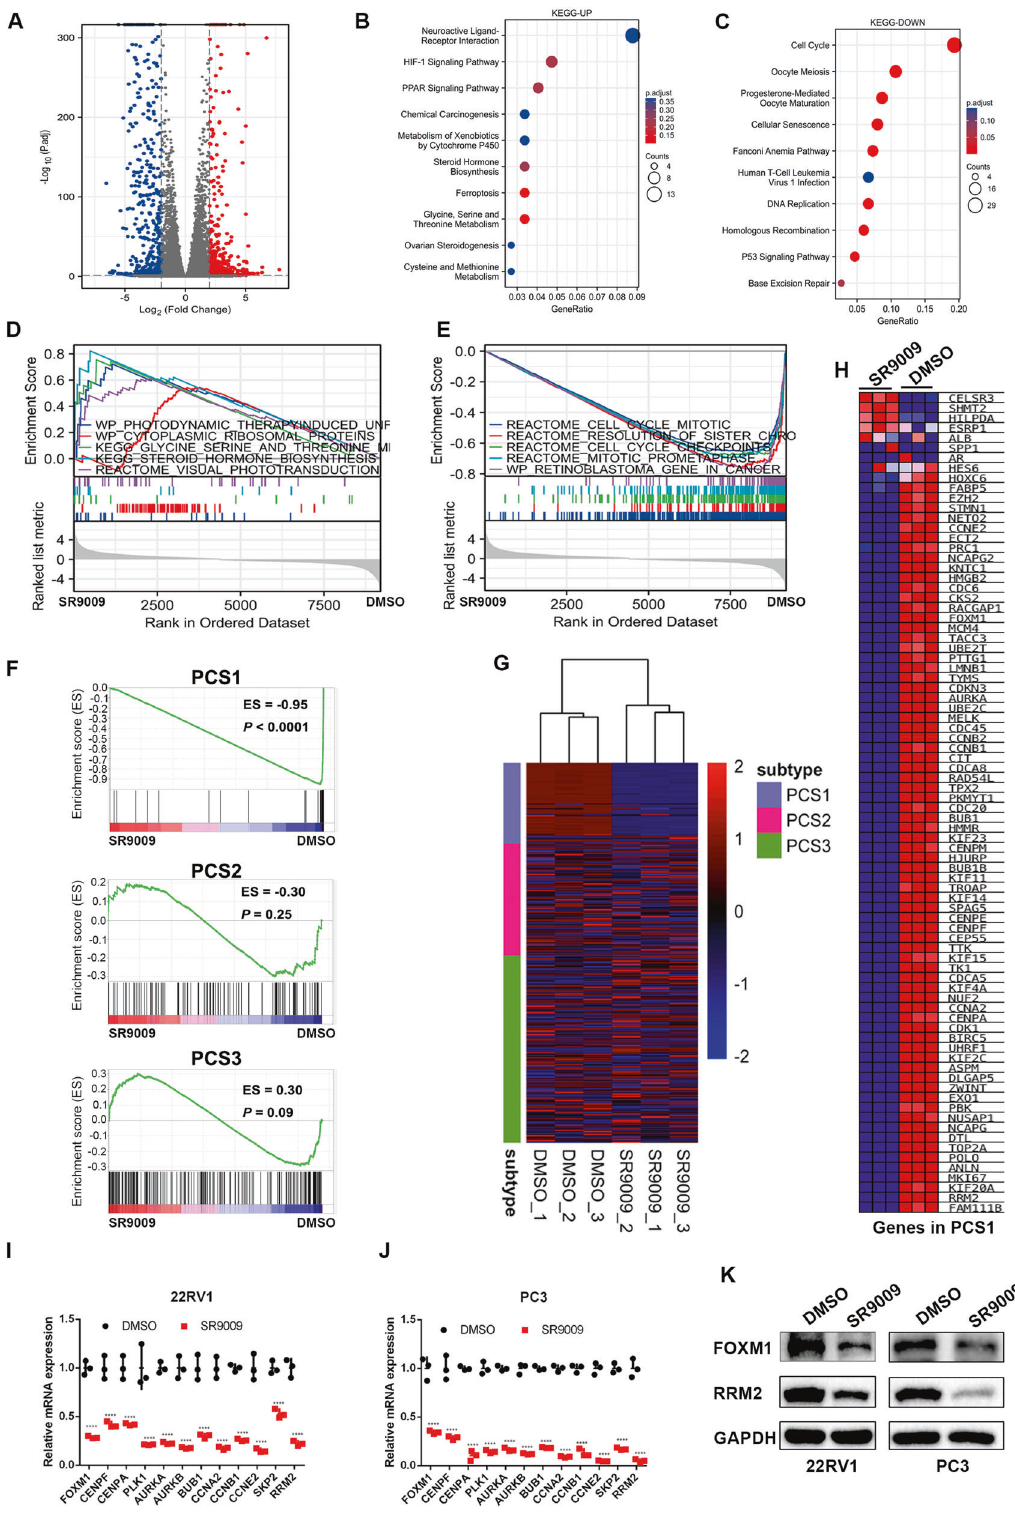
Fig. 2 SR9009 downregulated the cell cycle pathway and suppressed lethal prostate cancer subtype 1 (PCS1). A Volcano plot of differentially expressed genes between the SR9009 group ( n = 3) and DMSO group ( n = 3) after RNA sequencing. B , C Kyoto Encyclopedia of Genes and Genome (KEGG) pathway analysis of up- ( B ) and downregulated ( C ) pathways after SR9009 or DMSO was added; D , E Gene Set Enrichment Analysis (GSEA) analysis of the top 5 upregulated ( D ) and downregulated ( E ) pathways applying “ c2.cp.v7.2.symbols.gmt [Curated] ” from the MSigDB database. F GSEA of PCS1 after SR9009 or DMSO administration. G Cluster analysis of genes in PCS1, PCS2, and PCS3 between the SR9009 and DMSO groups. H Heatmap of genes in PCS1 after SR9009 or DMSO administration. I , J qPCR validations of genes downregulated in PCS1 in 22RV1 ( I ) and PC3 ( J ); n = 3; means ± SDs; ANOVA. K Western blot validation of SR9009 treatment on the expression of FOXM1 and RRM2 in PC3 and 22RV1 cells. ns, not signi fi cant; * p < 0.05; ** p < 0.01; *** p < 0.001; **** p < 0.0001. Cell Death and Disease (2022)